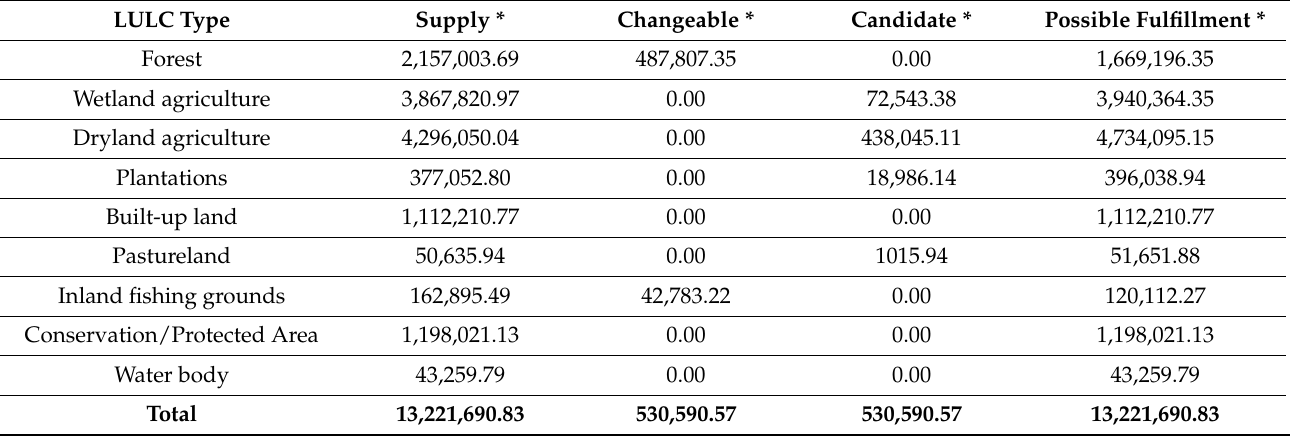
Table 12. The possible allocation fulfillment of land-use/land cover in Java Island based on the 519 land suitability. 520 * Unit area in hectares